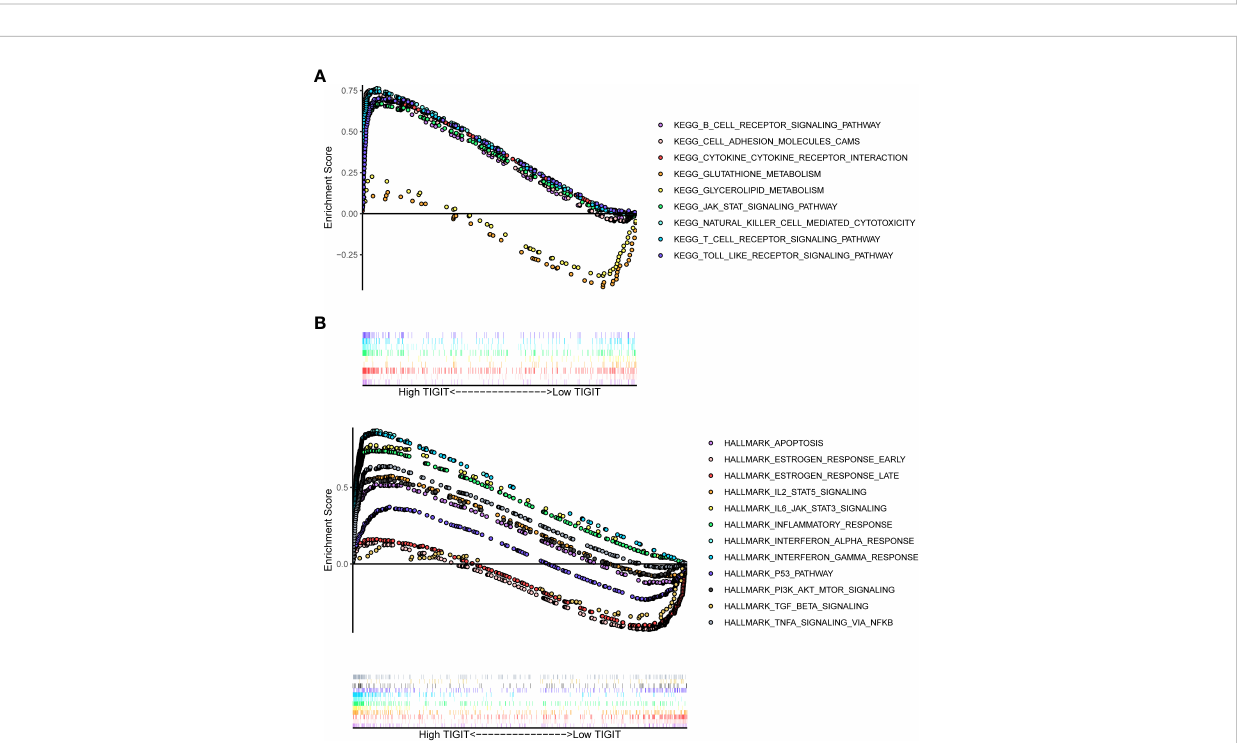
FIGURE 6 Differential enriched functions or pathways correlated with the expression of TIGIT. (A) Differential enriched KEGG pathways associated with the expression of TIGIT in KIRC. (B) Differential enriched HALLMARK pathways associated with the expression of TIGIT in